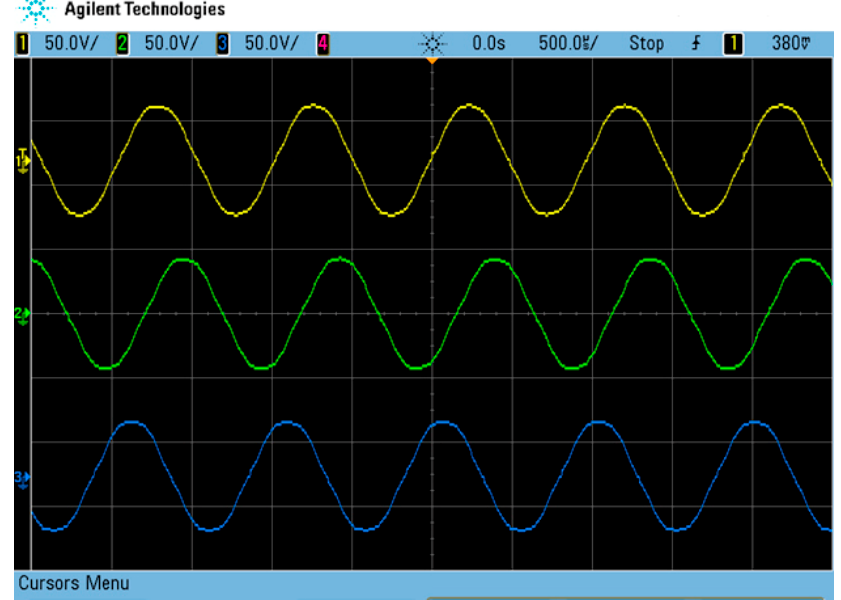
Figure 12. Line voltages with the generator rotating at 6156 RPM. Frequency: 1026 Hz.